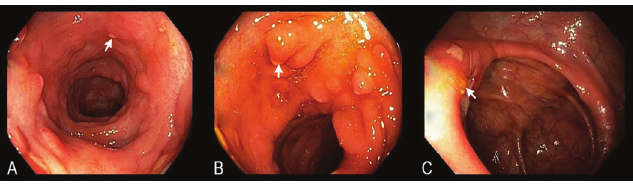
Figure 1 - Colonoscopy findings in a patient under infliximab and azathioprine treatment: (A, B) arrows show aphthous ulcers on the colon mucosa, (C) shows exudative ulcers at the level of the ileocecal valve (arrow).